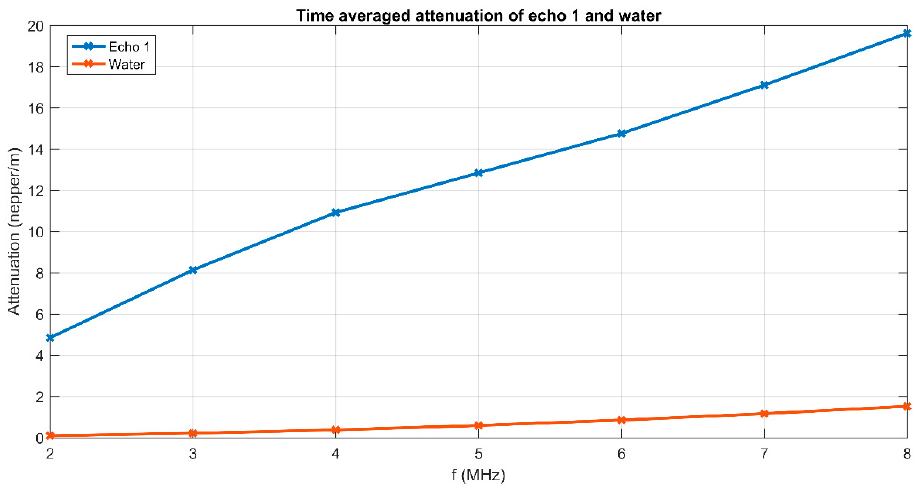
Figure 5. Spectrum amplitude ratios of the sample relative to the reference sample.